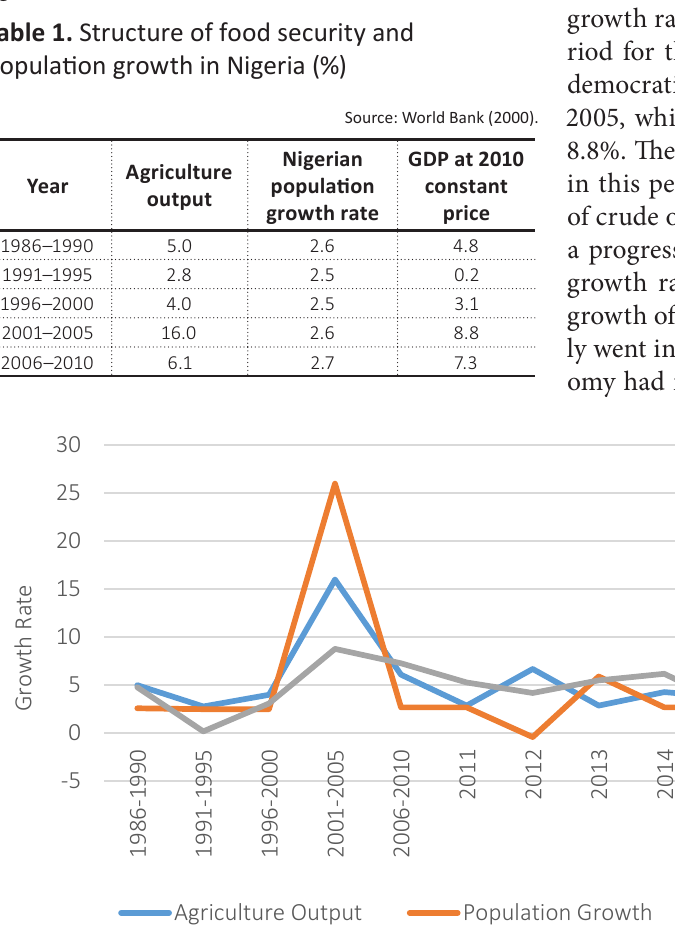
Figure 1. Trend of food security and population growth in